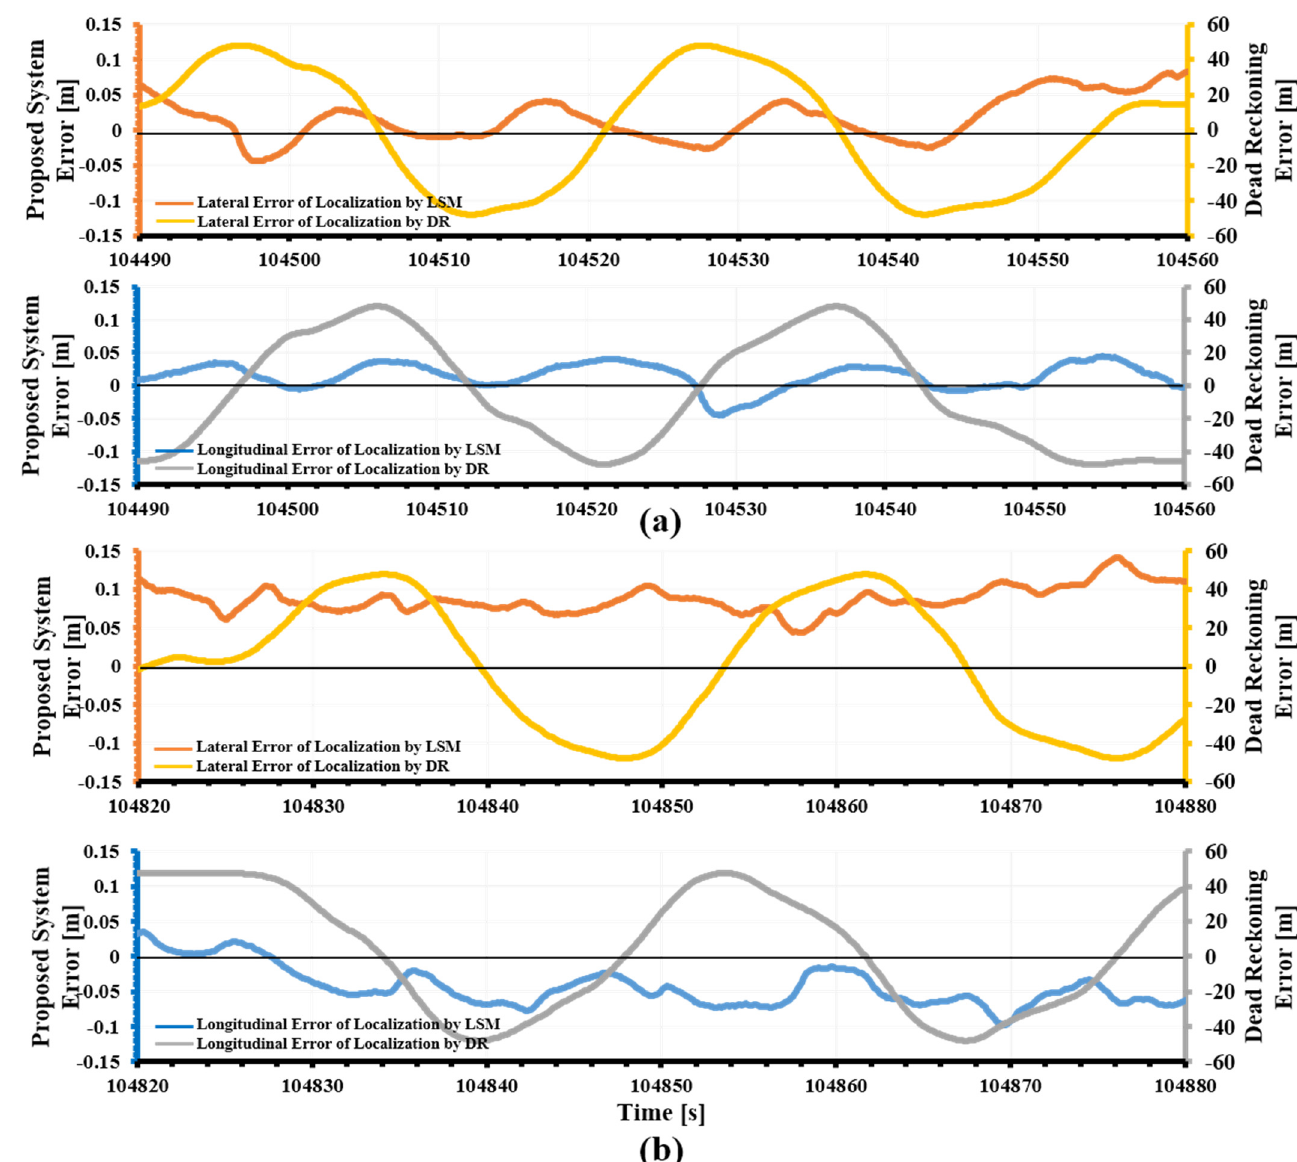
Figure 14. Localization in XY plane. ( a ) Lateral (top) and longitudinal (bottom) errors of the proposed localization system and the DR in the two upward loops compared to GIR ground truth. The RMSE errors of the dead reckoning and proposed localization module in the lateral and longitudinal direction are 0.048 m, 27 m, 0.037 m and 29 m, respectively. ( b ) Lateral and longitudinal errors in the downward two loops. The corresponding RMSE errors of the dead reckoning and proposed localization module in the lateral and longitudinal direction are 0.087 m, 28.8 m, 0.049 m and 31.2 m, respectively.